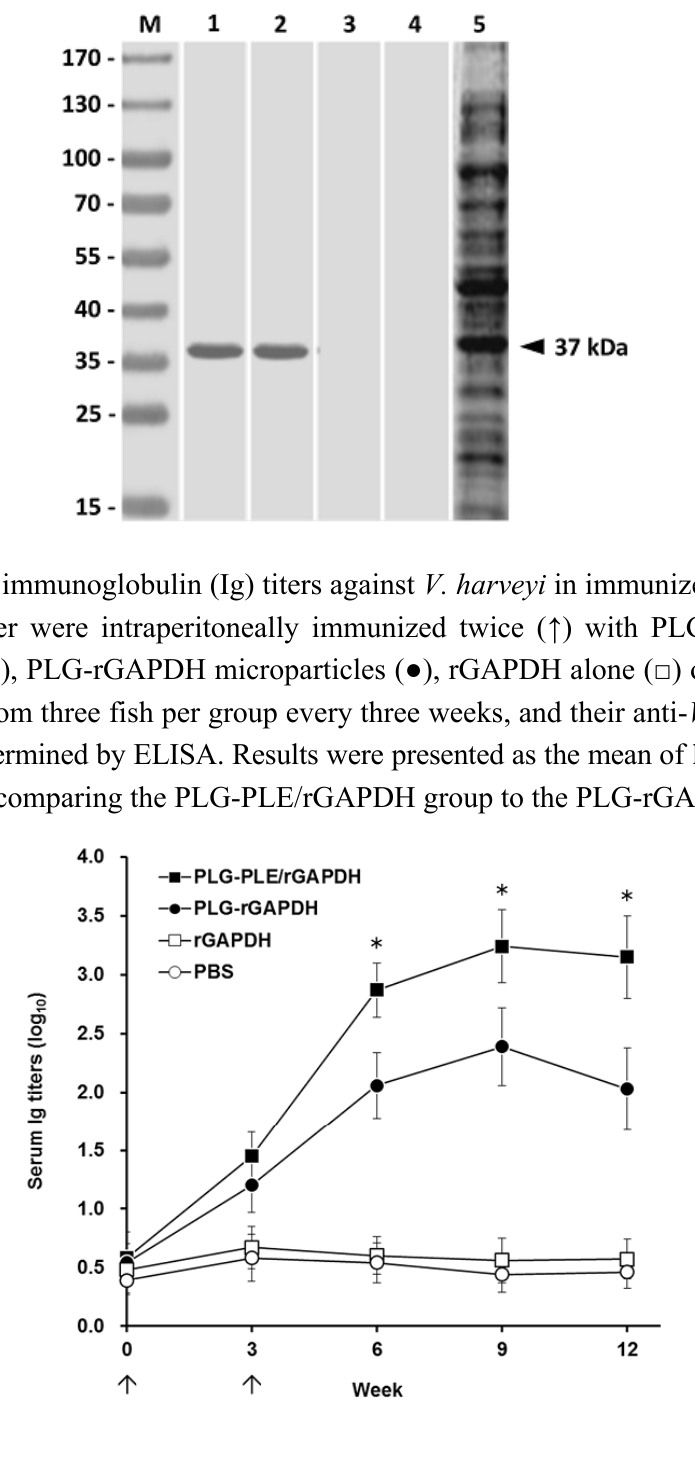
Figure 4. Antigenic specificity in immunized grouper sera. Three weeks after boosting, grouper sera were collected to analyze their antigenic specificity. V. harveyi lysate was probed with sera from grouper peritoneally immunized with PLG-PLE/rGAPDH microparticles (Lane 1), PLG-rGAPDH microparticles (Lane 2), rGAPDH alone (Lane 3) or PBS (Lane 4). The V. harveyi -infected grouper serum was also conducted (Lane 5). Standard protein markers (Lane M) are shown on the left.